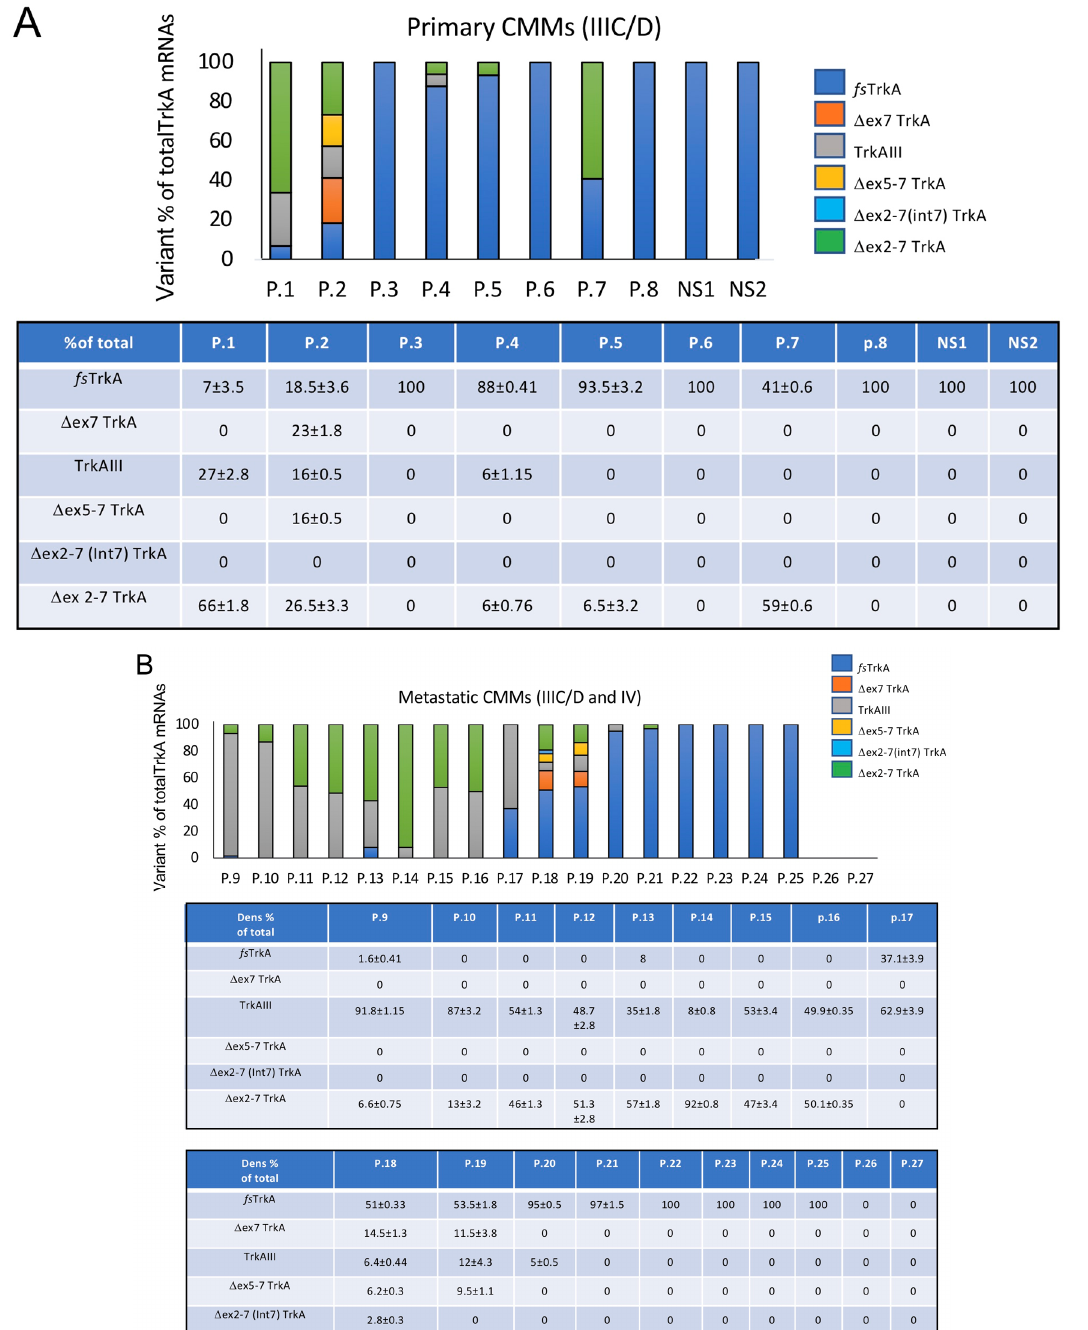
in FFPE CMM tissues. The nonsense splice variant Δexon 2–7 TrkA was predominant in 2 of 8 (25%) primary CMMs and 4 of 19 (≈21%) metastatic CMMs (Figures 1 and 2, and Supplementary Figure S1). Detection of this variant suggests suppression of nonsense-mediated RNA